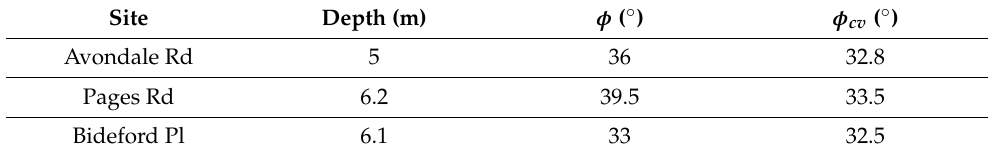
Table 1. Measured peak and residual friction angles of Christchurch sand samples from 3 different sites. Site Depth